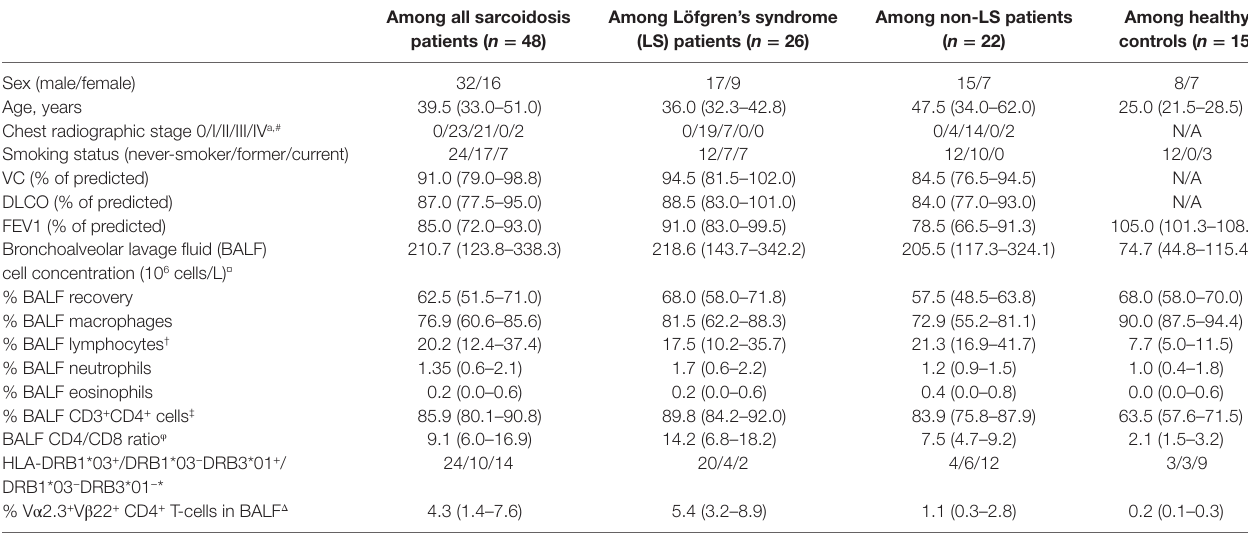
TaBle 1 | Clinical characteristics of sarcoidosis patients and controls.